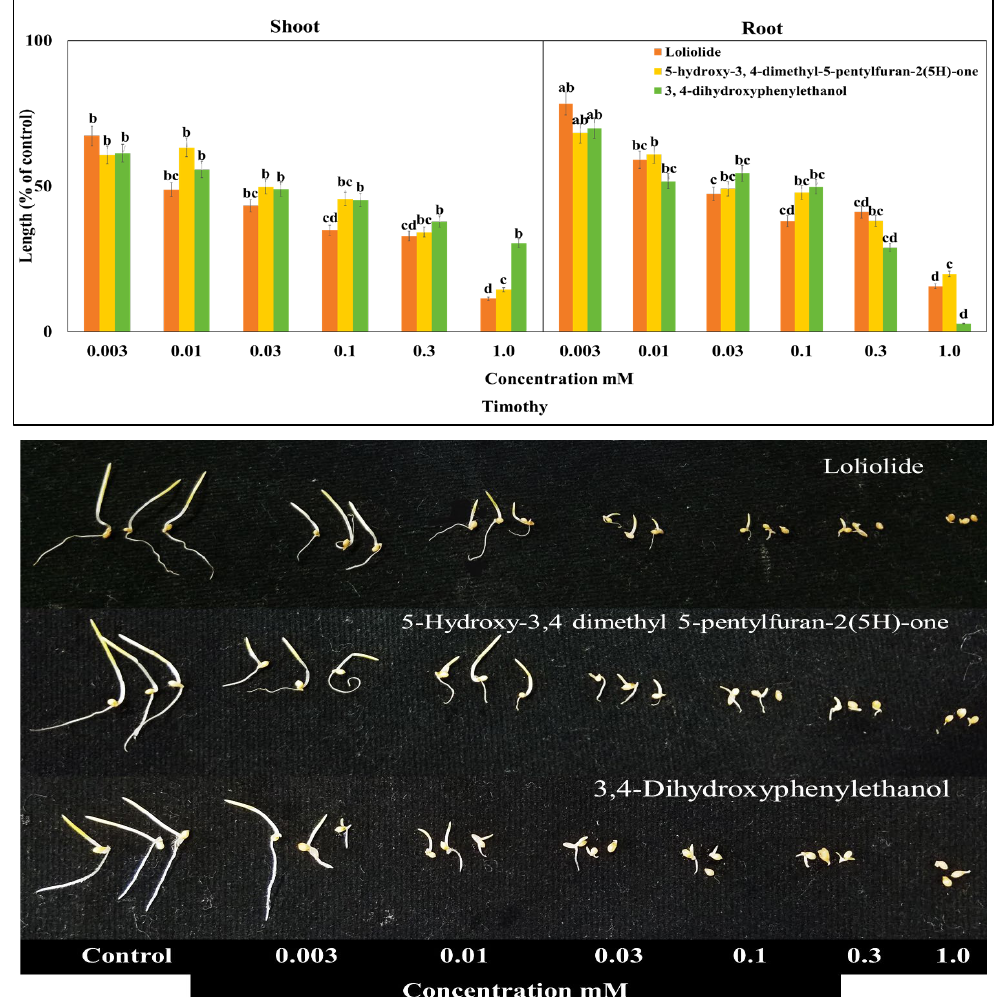
Figure 6. Effects of loliolide, 5-hydroxy-3,4-dimethyl-5-pentylfuran-2(5H)-one, and 3,4-dihydroxy- phenylethanol treatment on the growth of timothy seedlings. Mean ± SE of each experiment replicated 3 times ( n = 30). Differences between control and treatment are represented by different letters (Tukey’s HSD at p ≤ 0.05). Table 2. I 50 values of loliolide, 5-hydroxy-3,4-dimethyl-5-pentylfuran-2(5H)-one, and 3,4-dihydrox- yphenylethanol characterized from A. reticulata leaf extracts for shoot and root growth inhibition of cress and timothy.